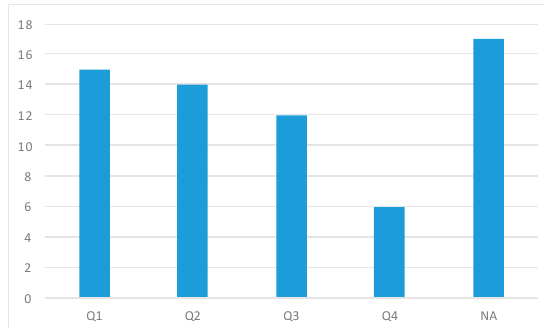
Figure 12. Quartile of journal publications.